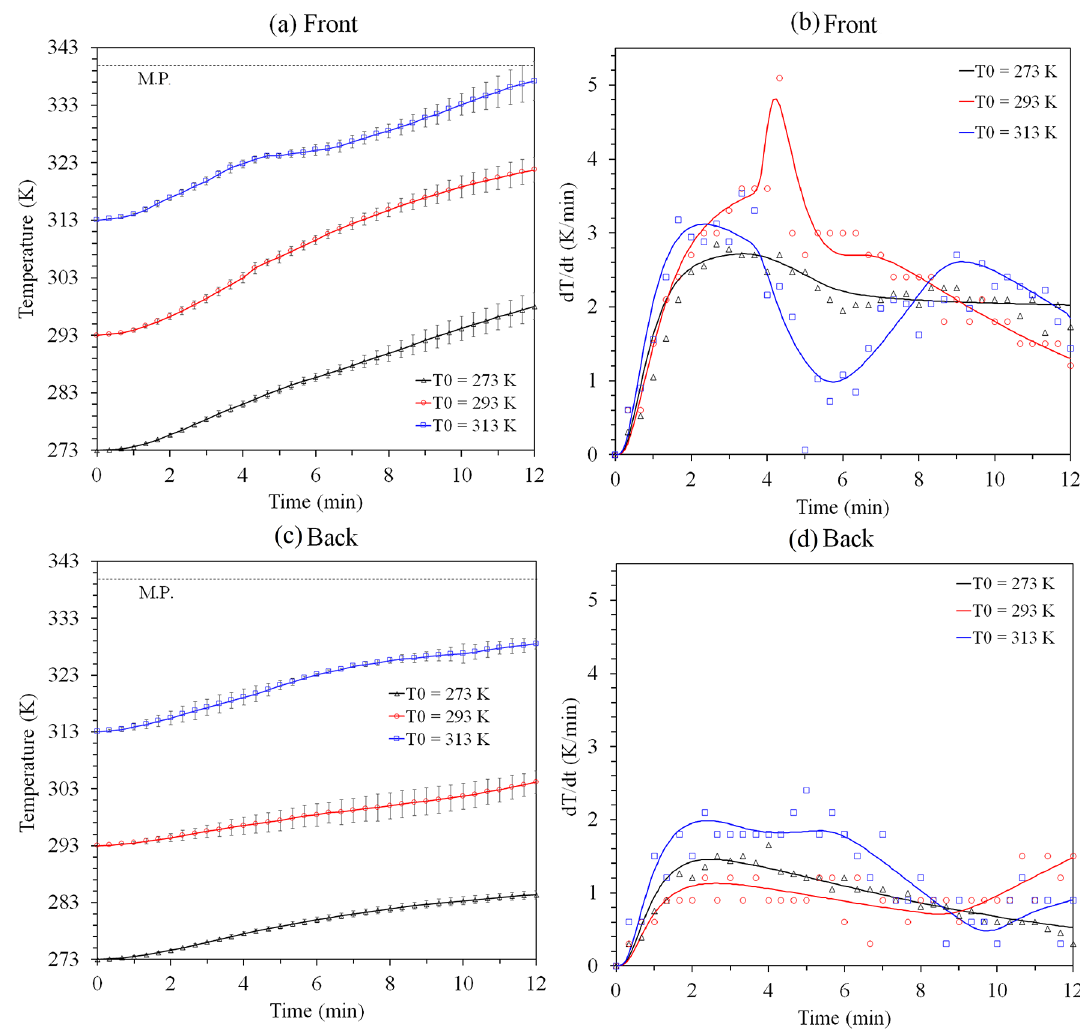
Figure 2. Experimental measurements of temperature in the region of thermocouple for the front position (a) and its instant variation measured (signals) and simulated (line) (b); measured temperature in the backt position (c) and its instant variation measured (signals) and simulated (line) (d). The dashed line indicates the value for the melting temperature (M.T.) of